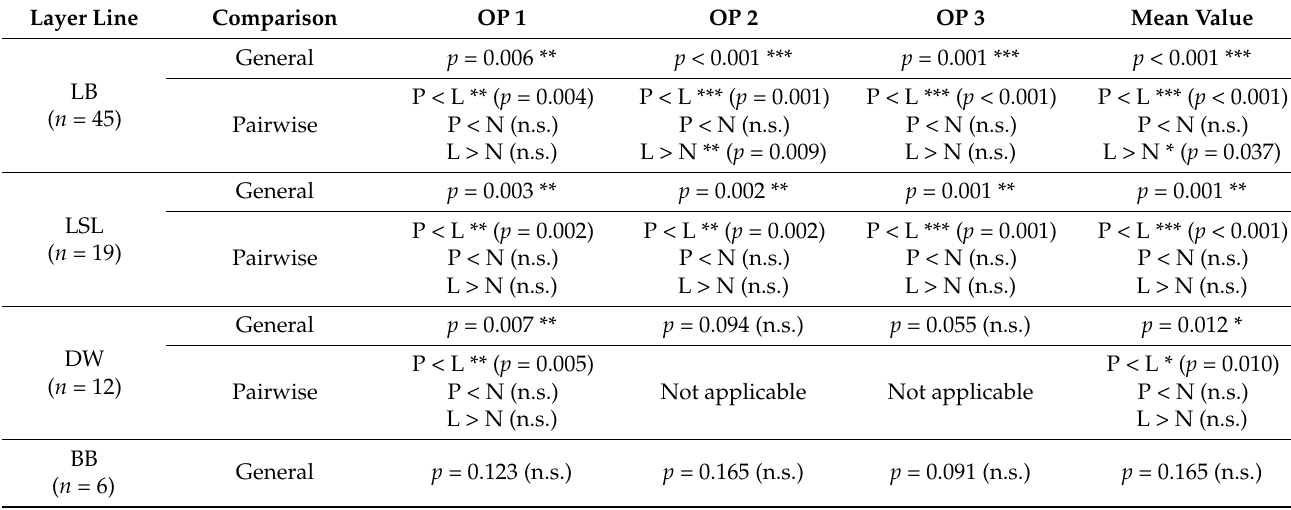
Table 3. Severe feather pecking in the three functional areas, perches (P), litter area (L) and nest-box area (N), shown for Observation Periods (OPs) 1–3 and for the whole laying period (mean value for OPs 1–3) 1 .